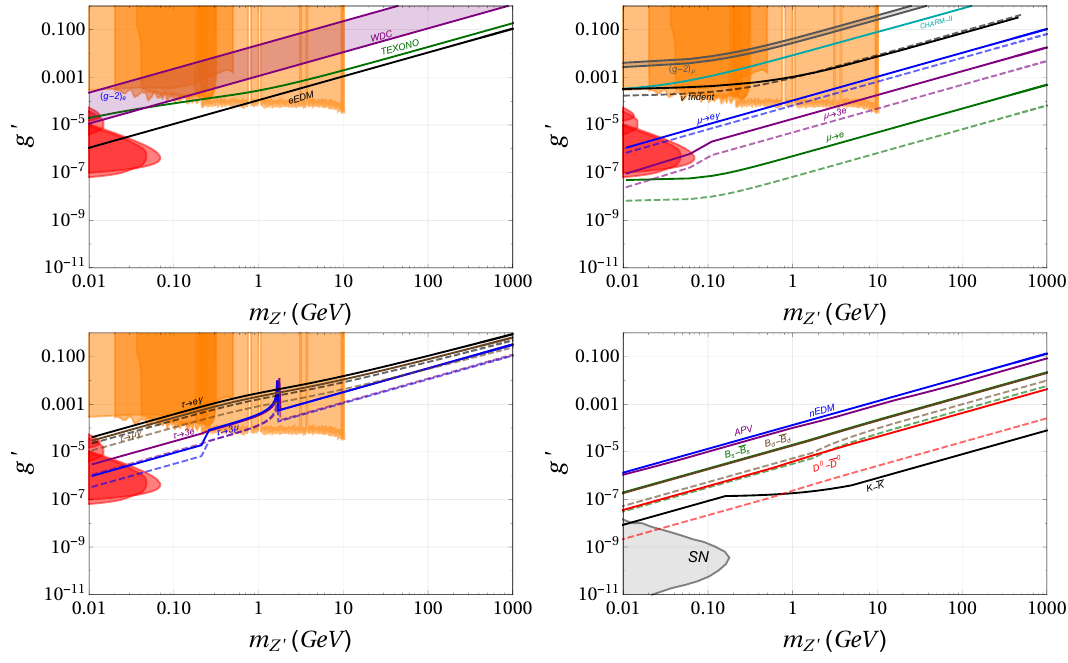
Figure 14 . The top panels and bottom left (right) panel show bounds on the Z 0 mass and the g 0 gauge coupling constant for the G FN = U(1) 0 model benchmark in the limit of no couplings to FN quarks (leptons). Direct Z 0 production searches exclude orange and red regions, cf. (cid:12)gure 13. Top left : bounds involving electrons, from the electron EDM ((cid:22) (cid:23) e e scattering, ( g 2) e , white dwarf (cid:0) (cid:0) cooling), shown as black line (green line, blue line, purple excluded region). Top right : bounds involving muons, from (cid:22) e conversion, ( (cid:22) 3 e , (cid:22) e(cid:13) , neutrino trident production, (cid:23) (cid:22) e ! ! ! (cid:0) scattering), shown as green (purple, blue, black, cyan) lines, while the gray region is consistent with ( g 2) (cid:22) . Bottom left : bounds involving taus, from (cid:28) 3 (cid:22) ( (cid:28) 3 e , (cid:28) (cid:22)(cid:13) , (cid:28) e(cid:13) ) shown (cid:0) ! ! ! ! (cid:22) K with blue (purple, brown, black) lines. Bottom right : bounds involving quarks only, from K (cid:0) (cid:22) D , B (cid:22) B (cid:22) B mixing ( D s (cid:0) s , B d (cid:0) d mixing, neutron EDM, APV), shown as black (red, green, brown, (cid:0) blue, purple) lines, while the gray region is excluded by SN1987A. Solid (dashed) lines give present (future) bounds, see text for